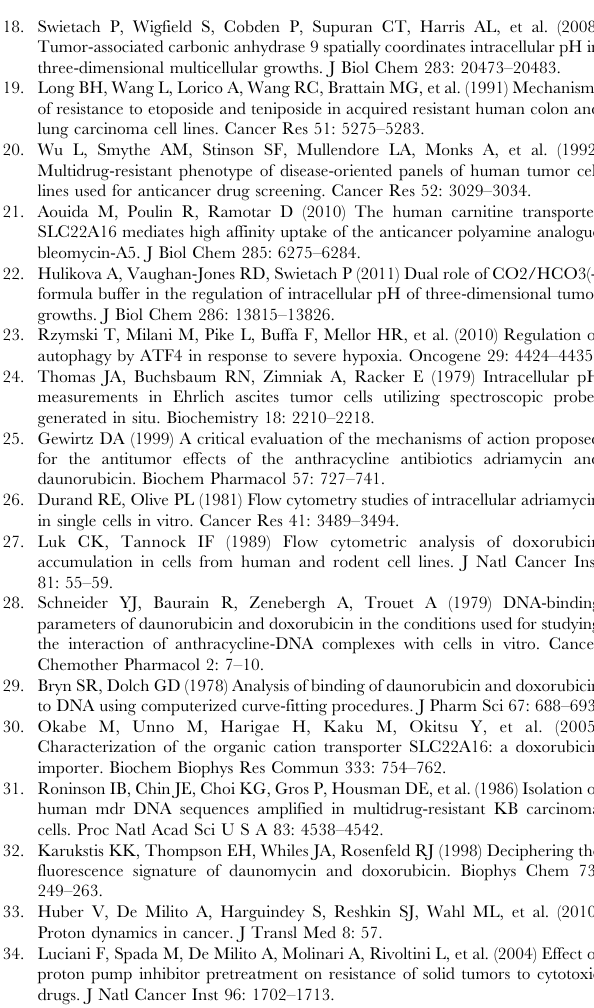
Figure S2 Measuring the nuclear versus non-nuclear doxorubicin accumulation. HCT116 monolayers were grown to confluency and then incubated in buffer solution (of desired pH and salt composition). Monolayers were then loaded with